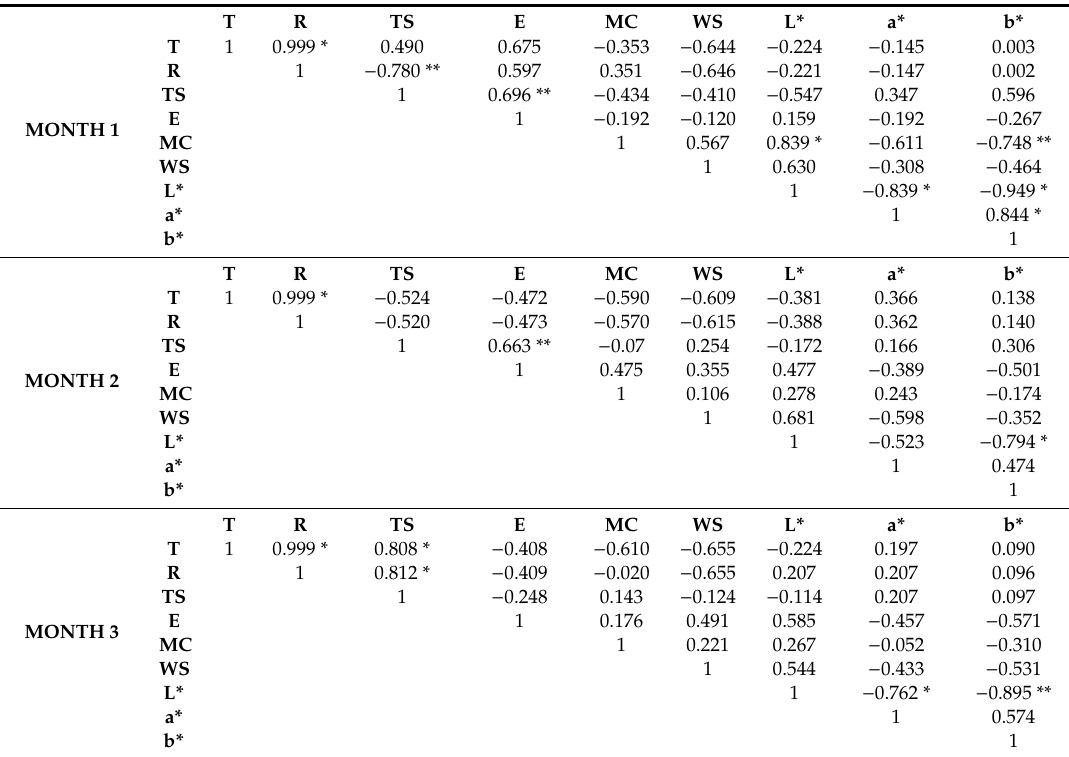
Table 2. Pearson correlation for characteristics of tested